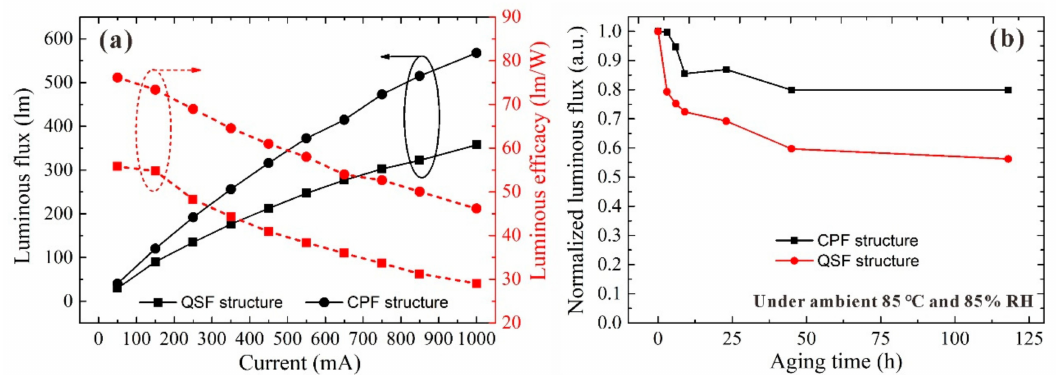
Figure 5. ( a ) Luminous flux and efficiency of LED devices with two kinds of structural films. ( b ) Normalized luminous flux during the aging process under 85 ◦ C and 85% RH